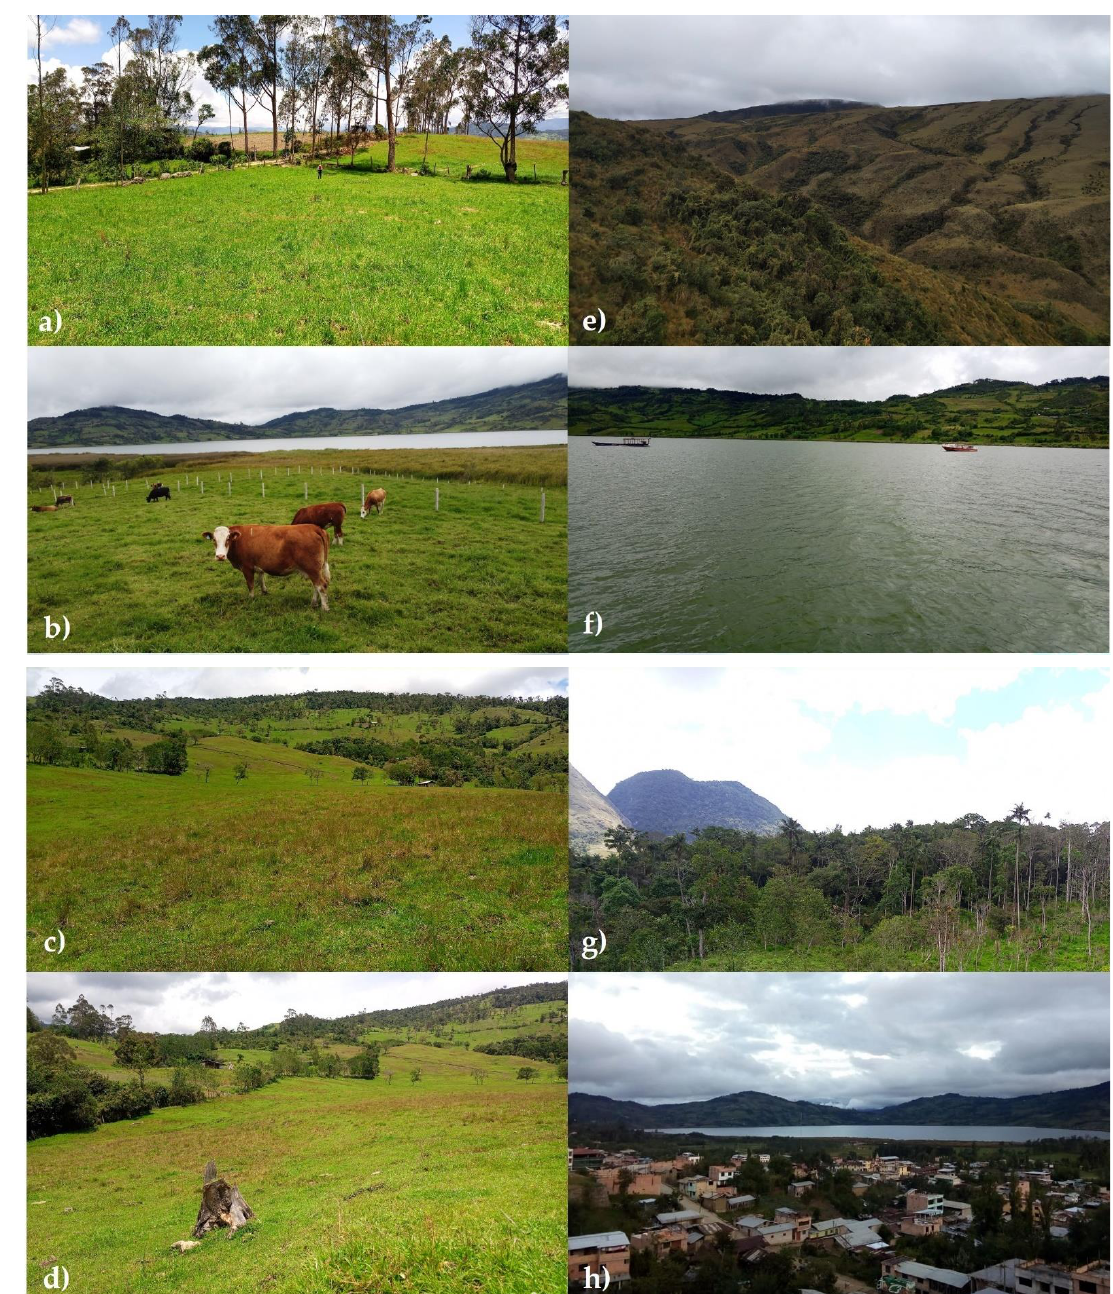
Figure 3. Training data collection using the GPS receiver in the Pomacochas and Ventilla micro- watersheds. Photos ( a ), ( b ), ( c ) and ( d ) show grasslands of intensive use in different stages, and photos ( e ), ( f ), ( g ) and ( h ) show non-grasslands, including andean grassland/scrubs, water, forest and urban areas, respectively.